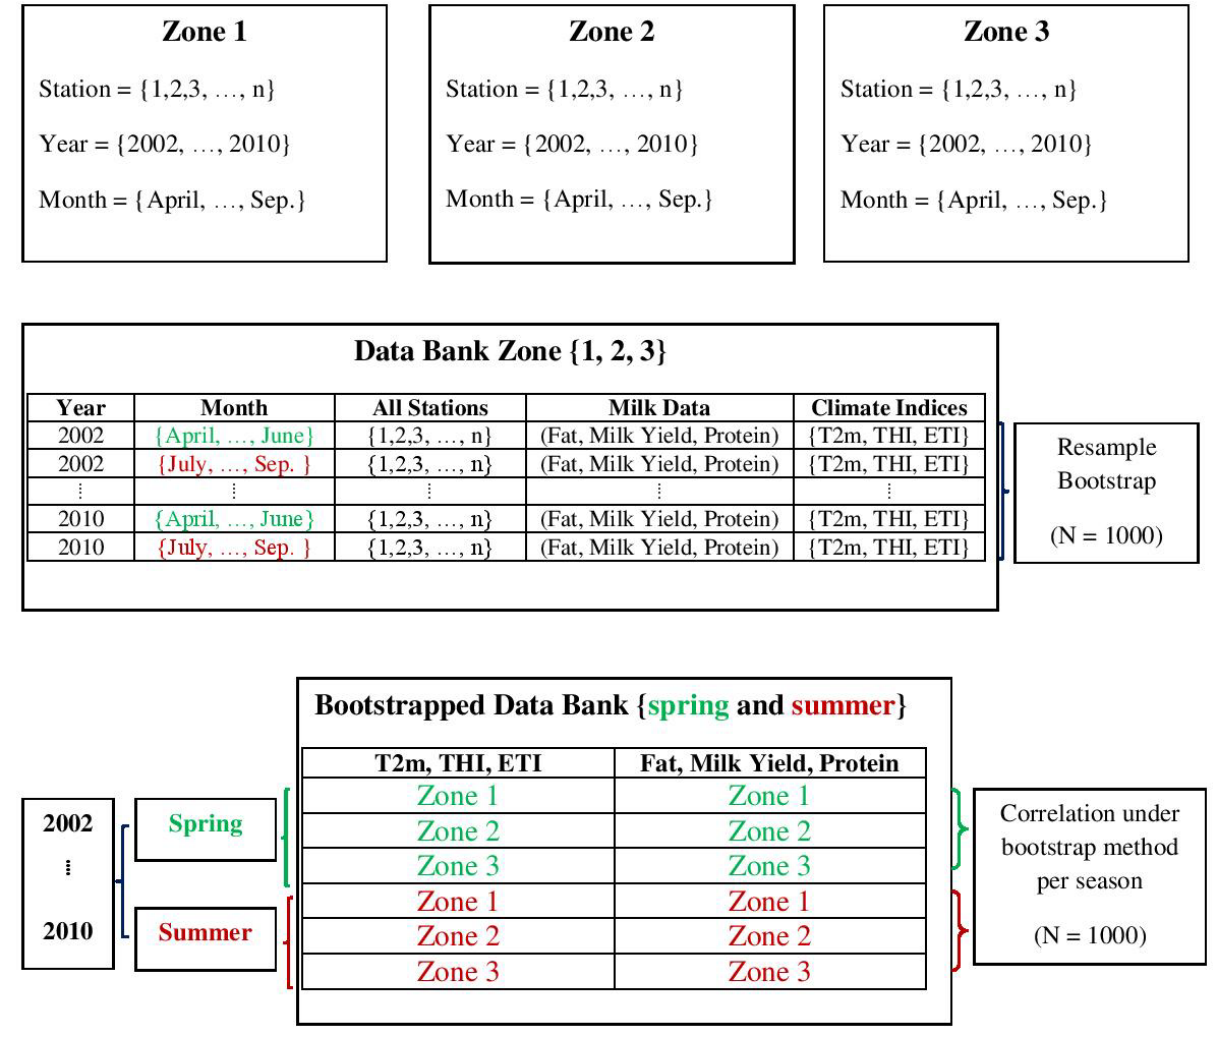
Figure 2. Flowchart of data